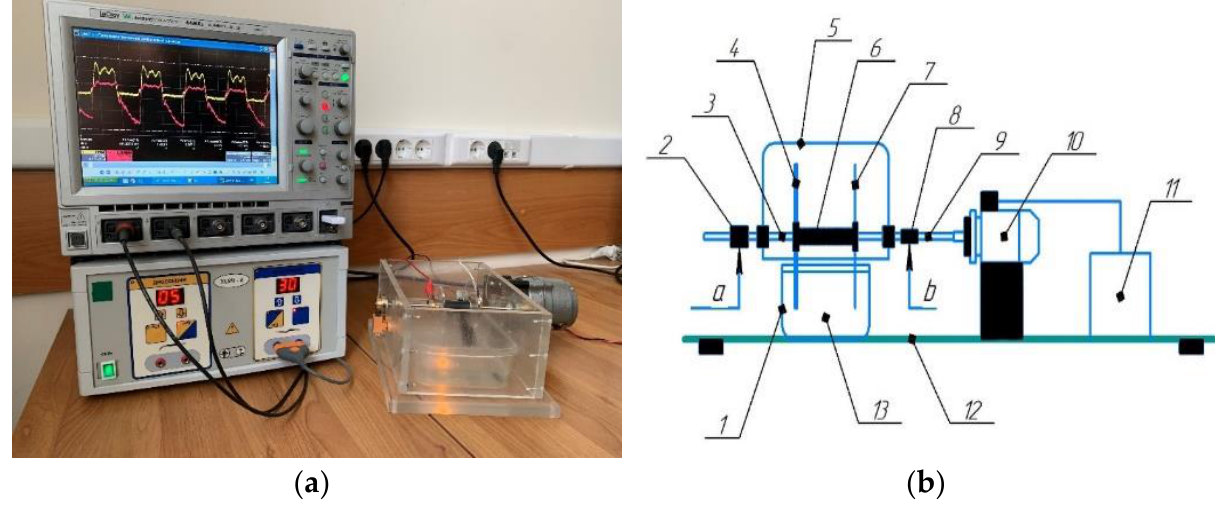
Table 1. Physical and chemical characteristics of the plasma-treated solution (PTS) after processing within 40 min.